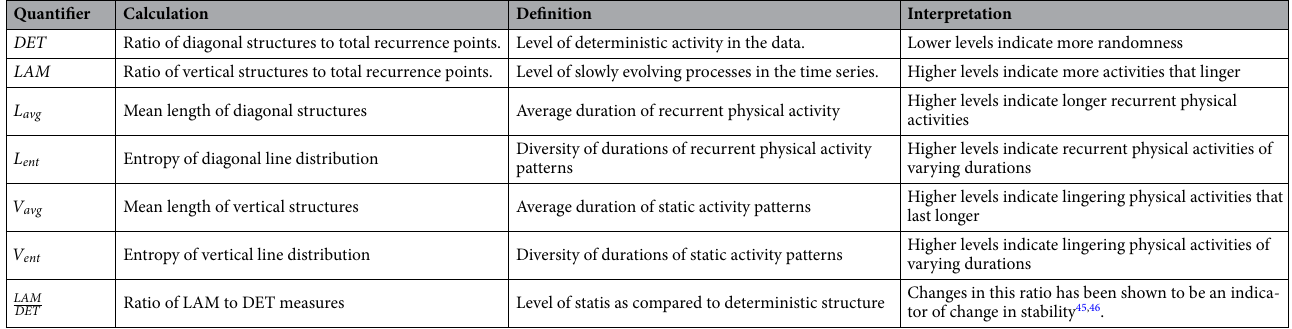
Table 1. Definitions and interpretations in the context of activity data, for various recurrence plot quantifiers that are used in this work. DET : Determinism; LAM : Laminarity; L avg : Average diagonal line length; L ent : Entropy of diagonal line distribution; V avg : Average vertical line length; V ent : Entropy of vertical line distribution; LAM DET : Laminarity to determinism